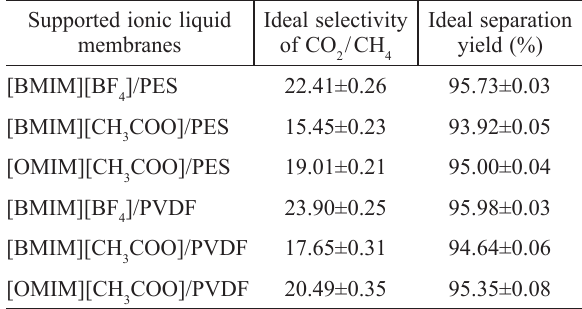
/ CH selectivity and performance of Table 8 – Ideal CO 2 4 SILMs Supported ionic liquid membranes